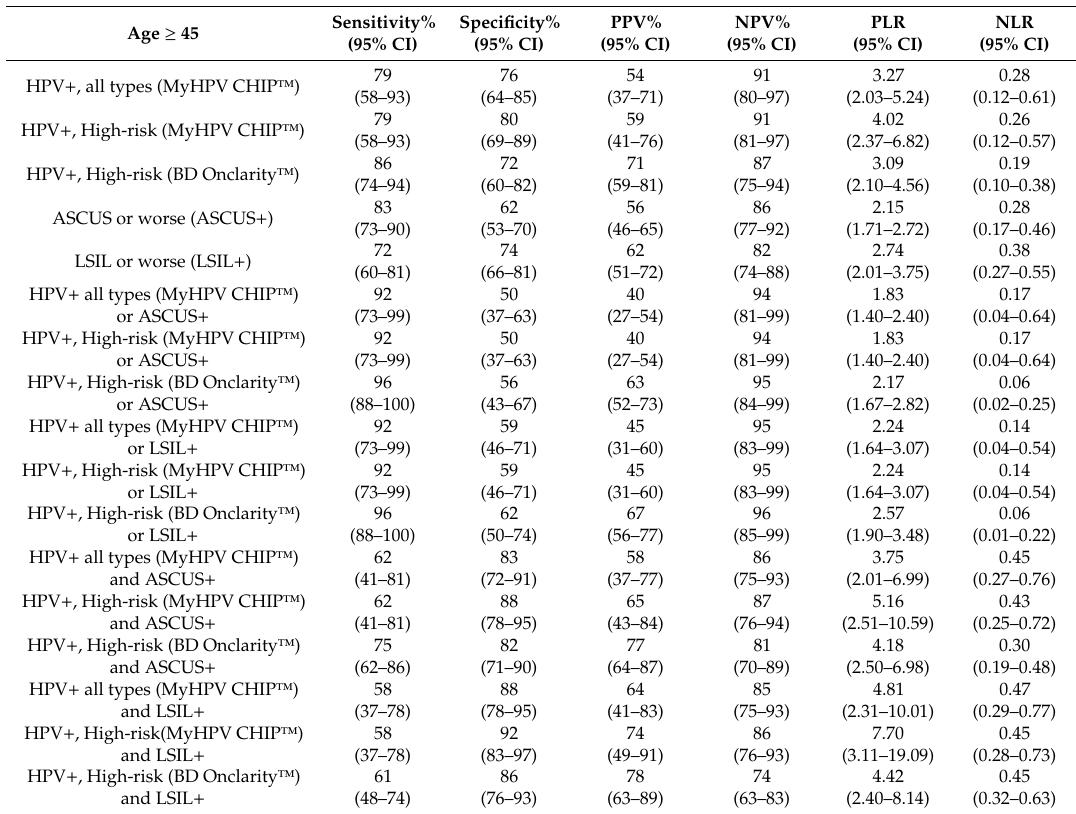
Table 14. Performance of HPV test combinations and cytology for the detection of CIN2 or worse (Age ≥